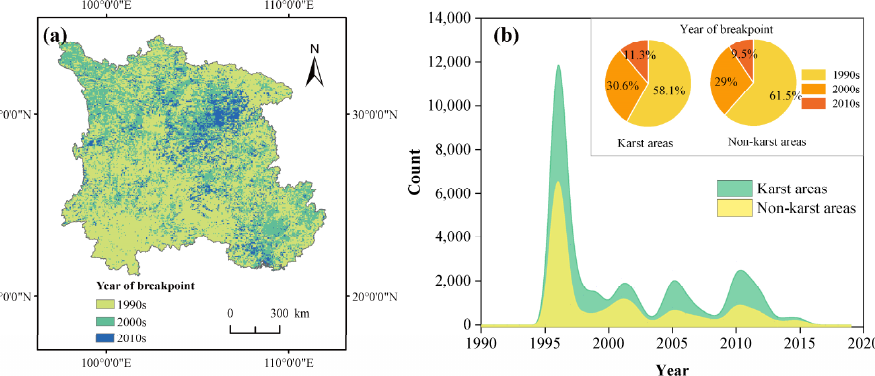
Figure 9. ( a ) Spatial distribution of the timing of breakpoints. ( b ) Timing of breakpoints in karst and non-karst areas.